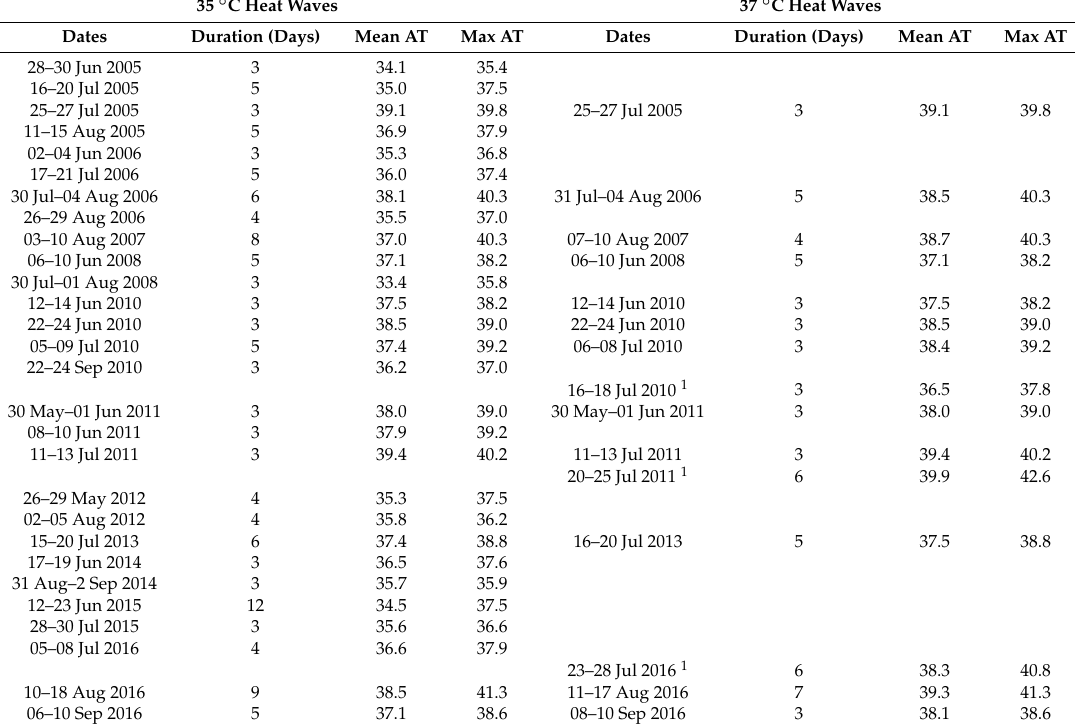
Table 3. Climatic details for the 28 heat waves using a 35 ◦ C apparent temperature (AT) threshold and the 15 heat waves based on a 37 ◦ C AT threshold.